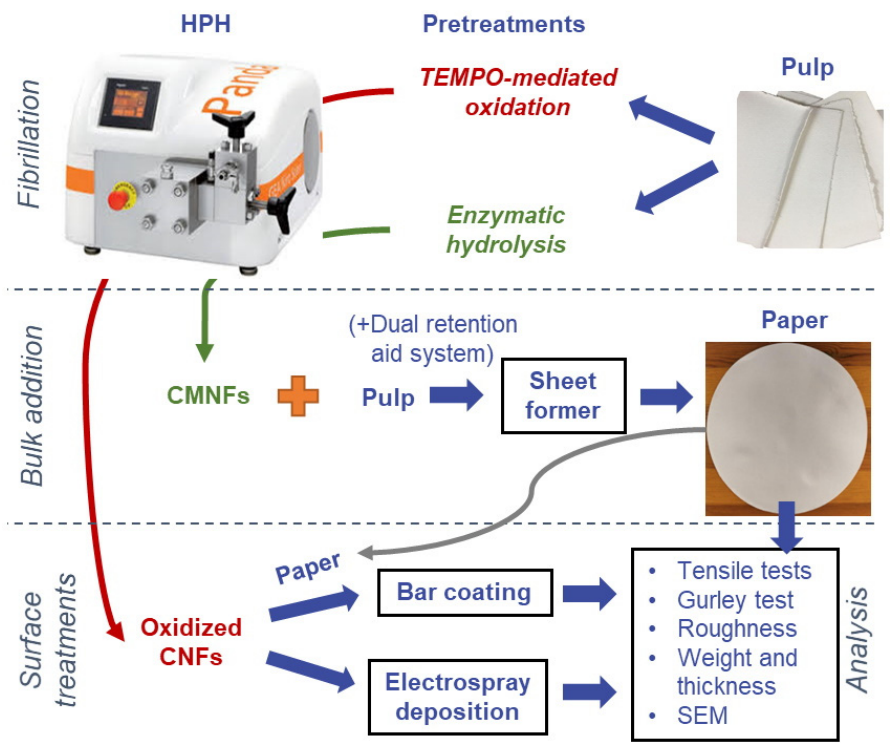
Figure 1. Diagram of the general experimental procedure, including fibrillation, sheet forming, bar coating, and electrospray deposition.